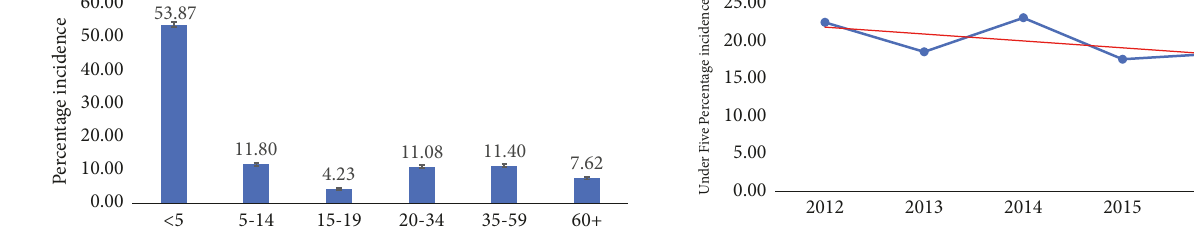
Figure 4: Under-five percentage incidence of diarrhea in Jasikan District